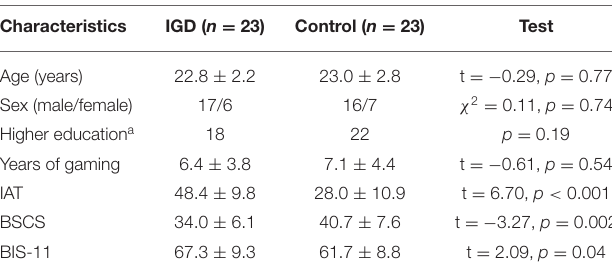
TABLE 1 | Characteristics of study